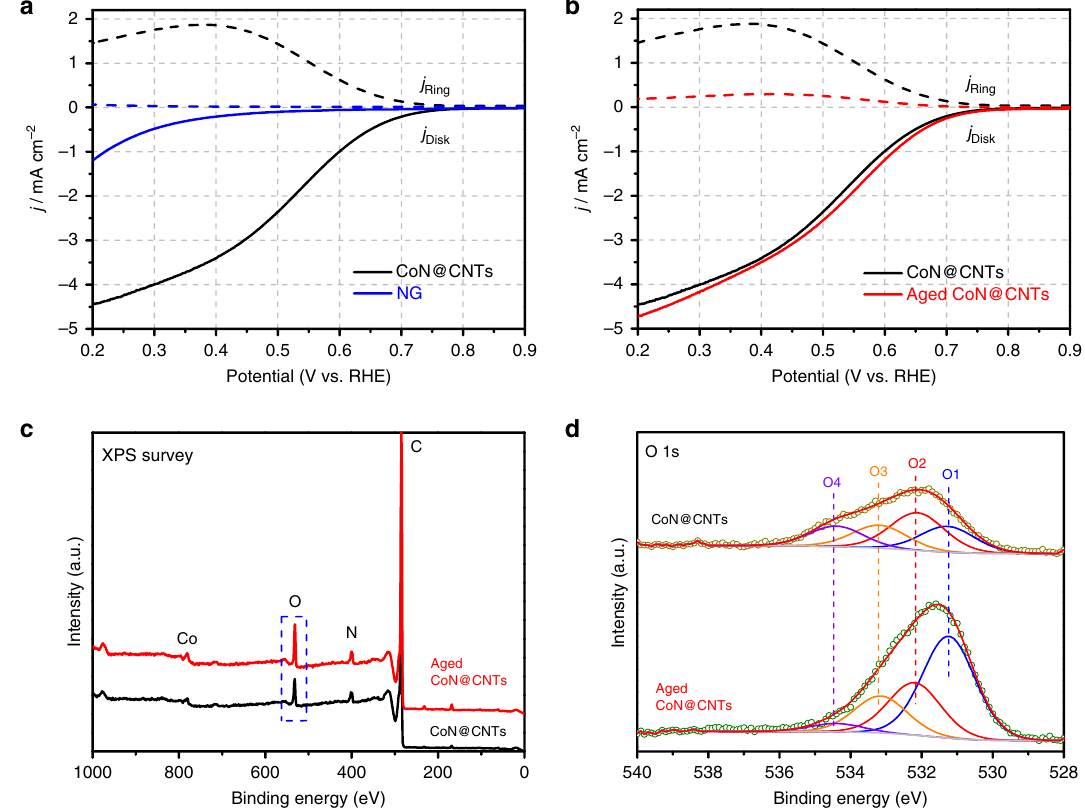
Fig. 2 Oxygen reduction performance of CoN@CNTs. a RRDE voltammograms of CoN@CNTs and NG at 1600 rpm in an O 2 -saturated 0.1 M HClO 4 electrolyte with disc current and ring current. b RRDE voltammograms of fresh and aged CoN@CNTs at 1600 rpm in an O 2 -saturated 0.1 M HClO 4 electrolyte with disc current and ring current. All potentials are recorded without iR correction. c XPS elemental survey of CoN@CNTs and aged CoN@CNTs. d XPS O 1s spectra of CoN@CNTs and aged